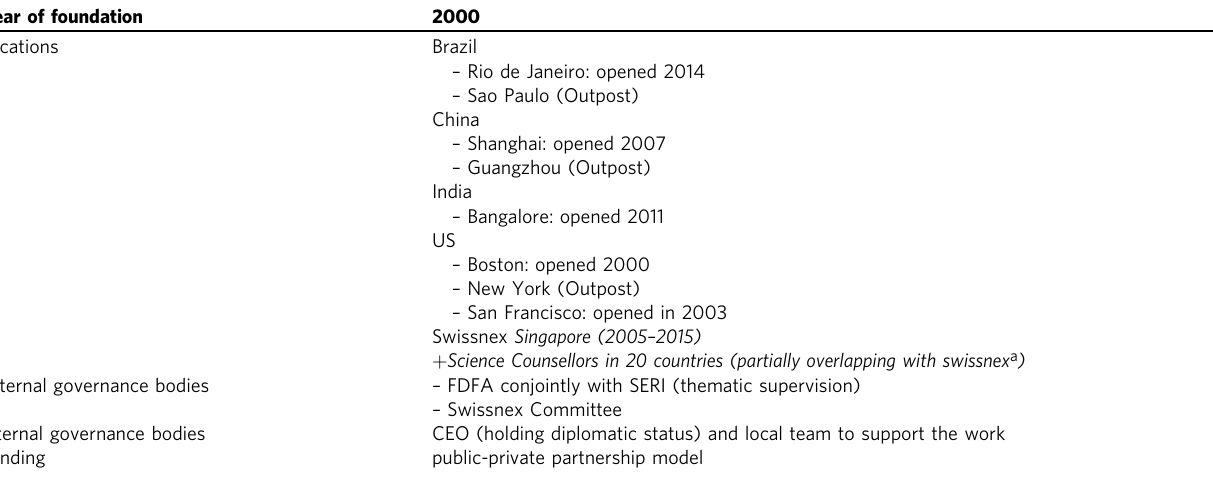
Table 2 Key characteristics